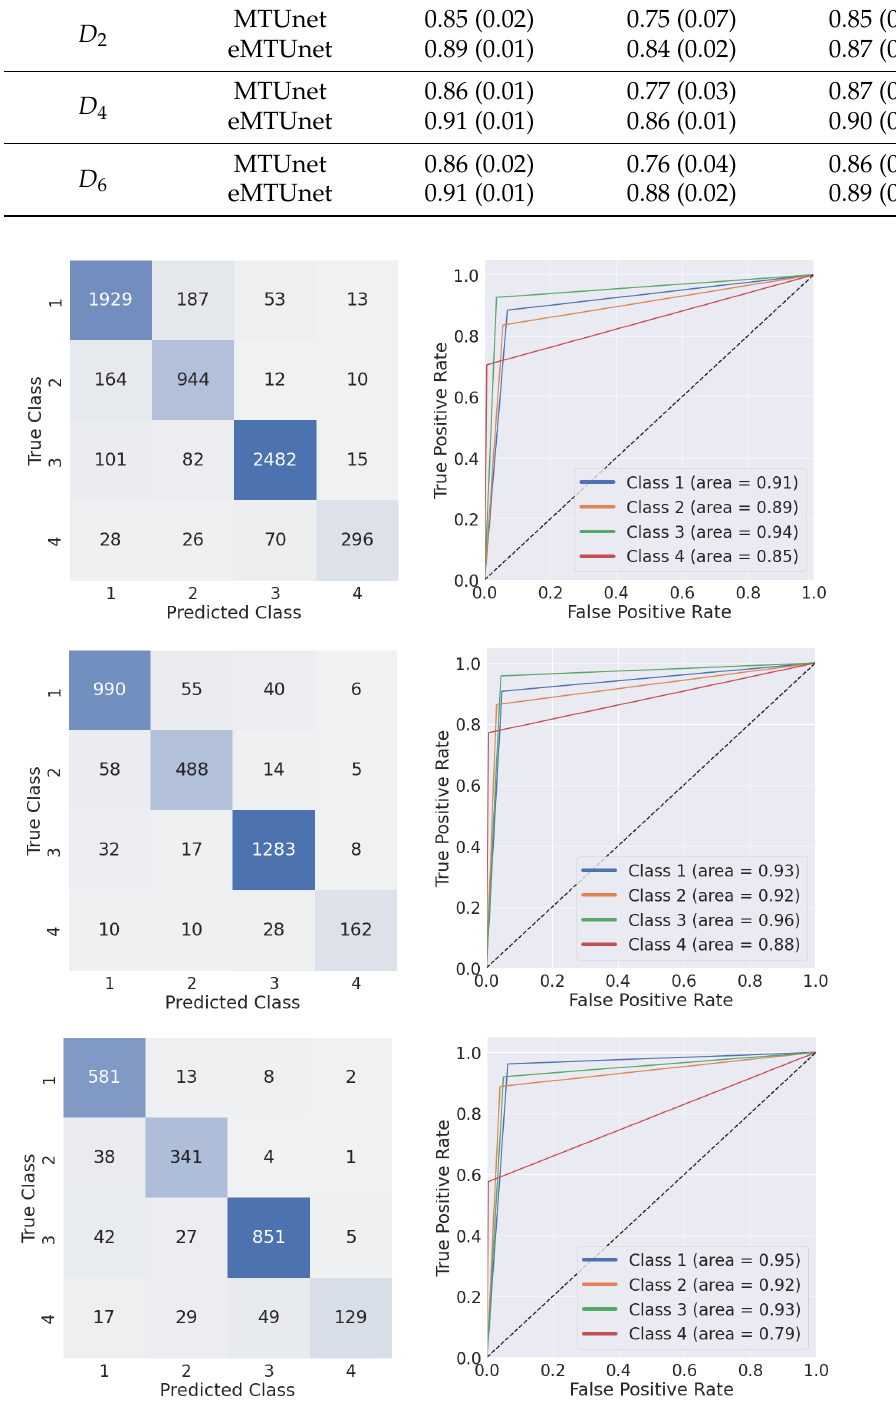
Figure 7. Multi-class confusion matrix and class-specific receiver operating characteristic curves computed with eMTUNet model trained with D 2 ( top row), D 4 ( central row), and D 6 ( bottom row) test